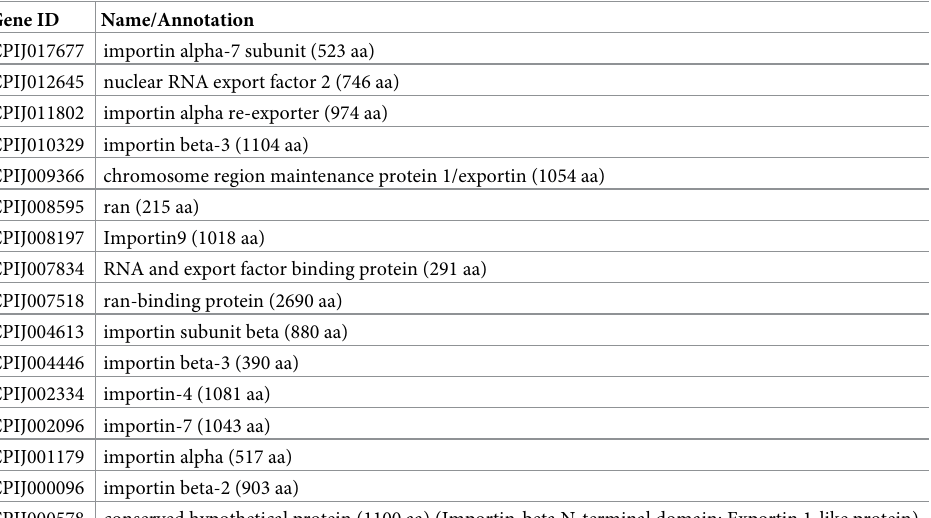
Table 4. Nuclear import/export proteins detected in the Culex sperm